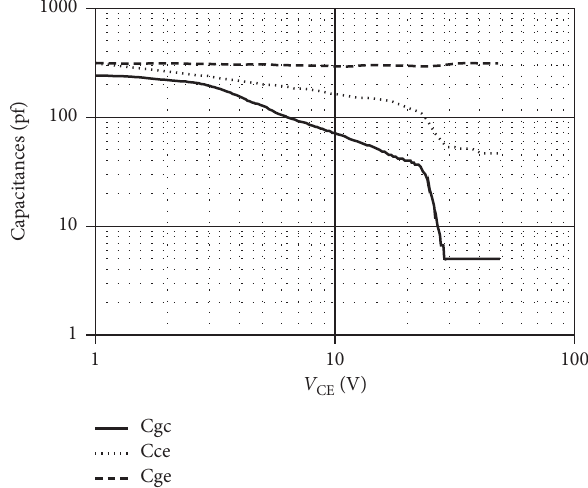
Figure 1: Curves of capacitances between terminals for the commercial IGBT (IRGBC20U) [18]. CGE capacity: its value is given by the system of equations